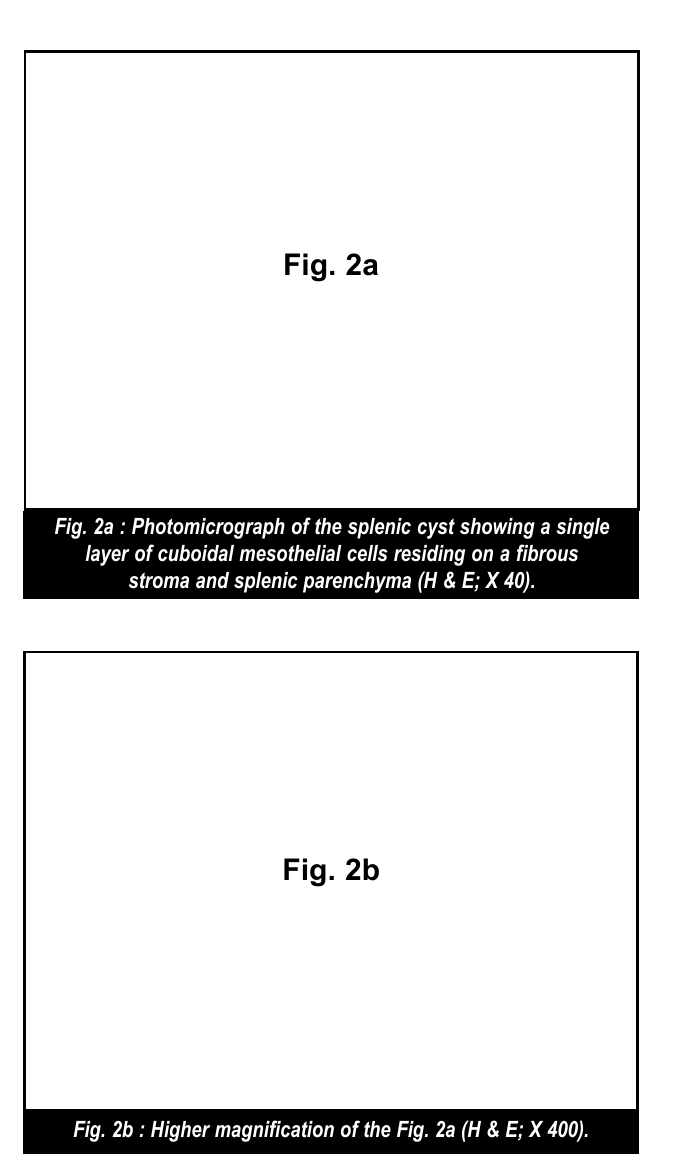
Fig. 1b : Specimen of splenic cyst, inner surface showing opaque white and trabeculated